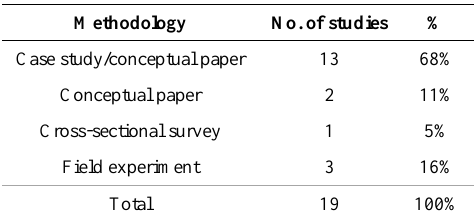
Table 3. Research methodology used in the